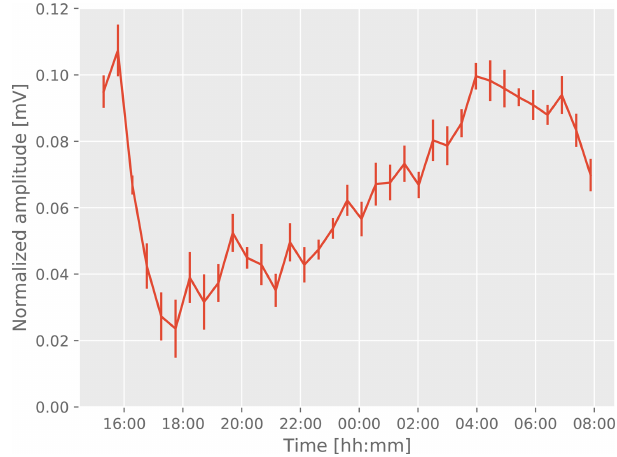
Figure 6. Measured amplitude for repeated measurements within series 7, 19kHz (23 August).